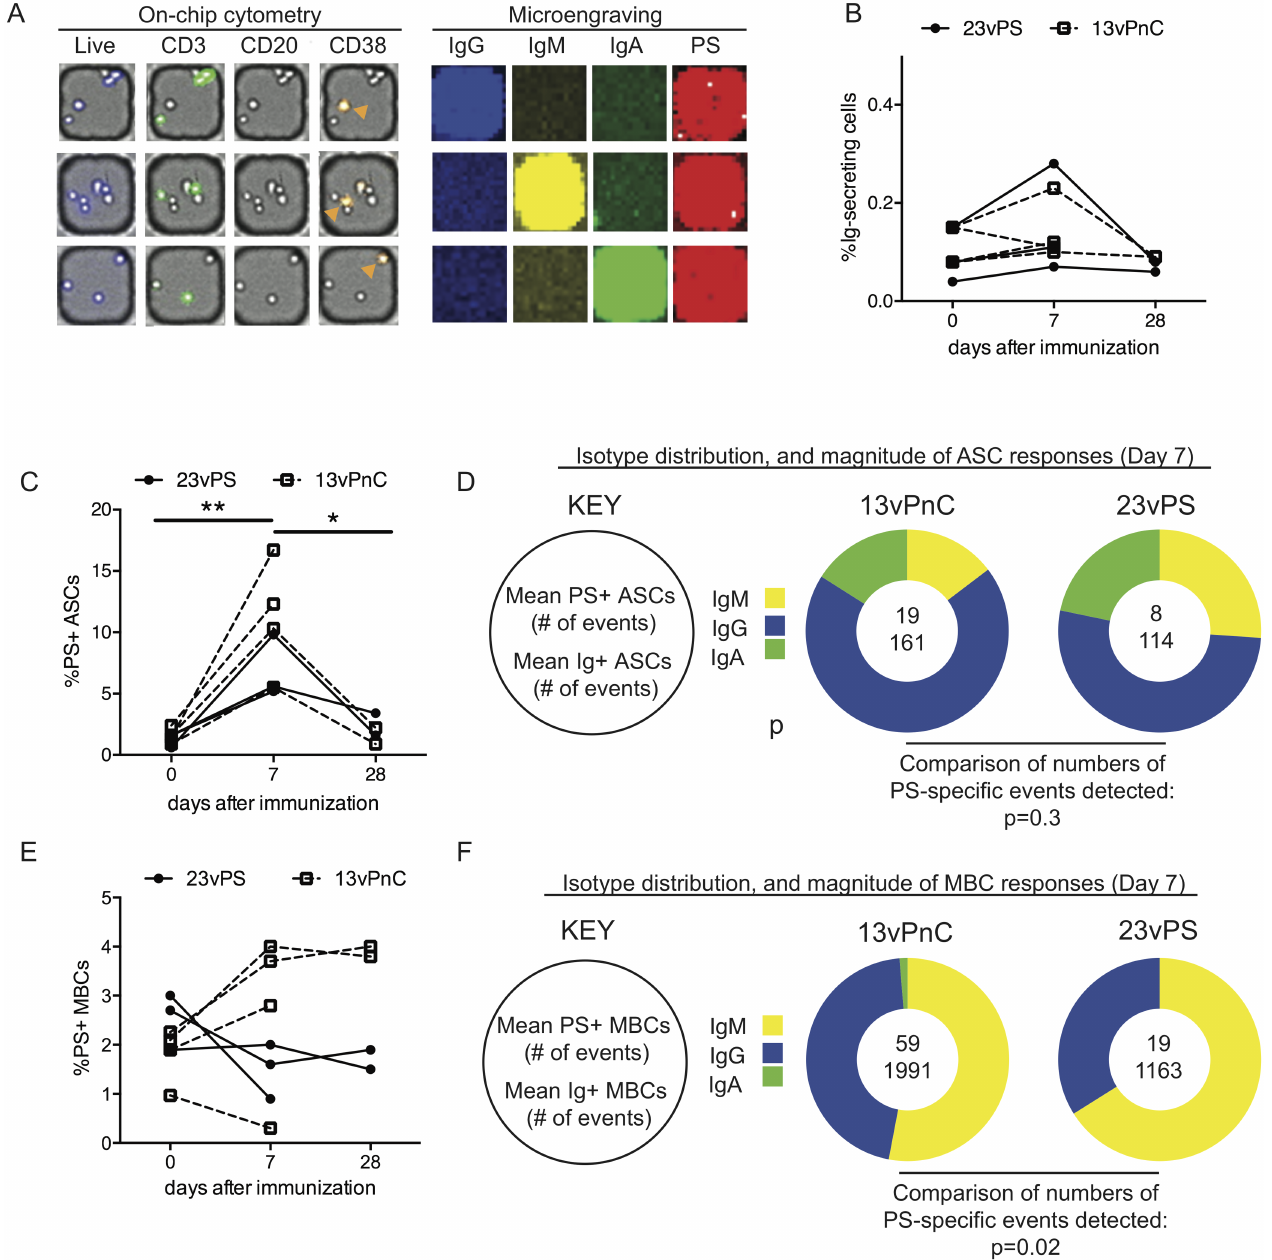
Fig 1. The averagefrequency of polysaccharide-specific antibody-secreting cells and memory B cells. (A) Representative images of 3 nanowells to illustrate the combination of on-chip imagingcytometry (left) with microengraving (right) in the analysisof circulating ASCs. Each horizontalrow shows one nanowell(left) and the corresponding print obtainedby micro-engraving (right). For images obtainedby on-chip cytometry, brightfieldimages of each nanowellare overlaidwith different fluorescence images demonstrating cell viability (violet), expressionof CD3 (green), expressionof CD20 (not detected)and expressionof CD38(yellow) for the cells in each nanowell. ASCs (Live, CD3 - CD20 - CD38 + ) are identifiedby orangearrows. Images obtained followingmicroengraving to measure the antibody secretionfrom each ASC are shown on the right. Secretion of IgG (blue), IgM (yellow),and IgA (green) were measured. Antigen specificity was determinedusing a fluorescently-labeledPS- protein conjugate (red). Images obtained for on-chip cytometry were obtained using AxioVisionRel. 4.7 (Zeiss) and spots from microengraving were analyzedusing Genepix 7.0 (Molecular Device). (B) Kinetics of the PS-specific circulating ASC response, represented as percent of PS- specific antibodysecretingcells amongtotal PBMCs from individualmacaquesboosted with either 13vPnC or 23vPS vaccinesat days 0, 7 and 28 post-vaccination. Frequencies of PS-specific ASCs were determined by dividingthe total number of PS-specific spots (specific for PS4, 6B, 14, and 23F) by the total number of PBMCs on the nanowellarray. The total number of PBMCs was obtained by countingthe total live cells using in-house software “Enumerator.” (C and E) Kinetics of the ASC (C) and MBC responses (E) representedas the percentageof Ig-secreting cells that are